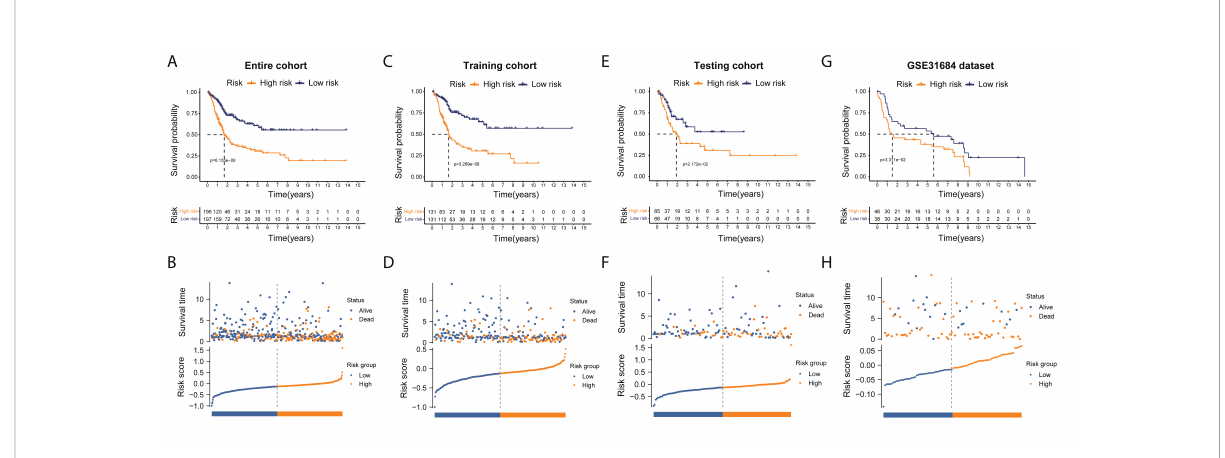
FIGURE 4 Risk score model establishment utilizing ERS-related lncRNAs. (A, C, E, G) The Kaplan-Meier analysis unveiled a signi fi cantly shorter OS of the high-risk group than that of the low-risk group in entire, training, testing cohorts, and GSE31684 dataset, respectively. (B, D, F, H) The overview of each patient ’ s survival status and risk rating distributions in entire, training, testing cohorts, and GSE31684 dataset,